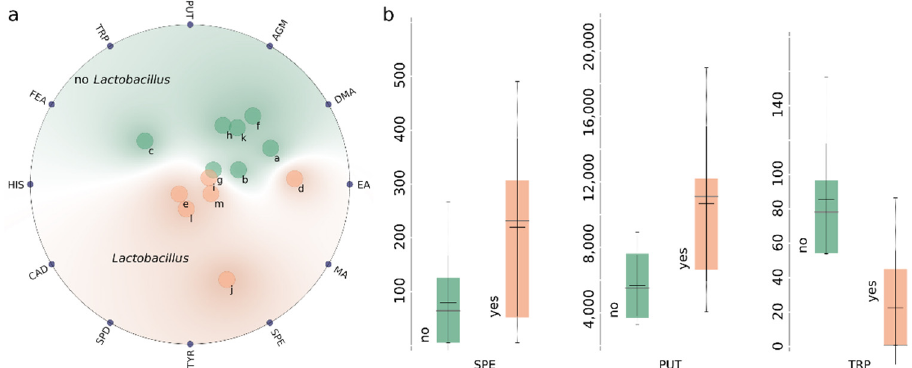
Figure 3. Untargeted (RadViz) analysis of commercial beer samples ( a ) and box plots for 3 most relevant BAs in terms of classification based on presence of lactic acid bacteria ( b ). Grey horizontal bars in box plots denote median values, and black horizontal bars denote average values. Labels in subplot ( a ): a-APA1, b-LGR1, c-WZN, d-PIN, e-LMBC, f-LGR2, g-LGR3, h-LGR4, i-BWS1, j-BWS2, k-APA2, l-GEU, m-SIPA.